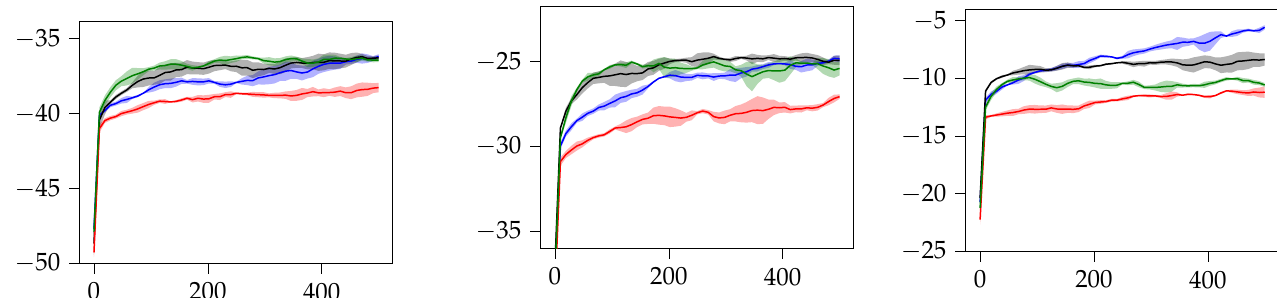
( b ) Total reward during training for the backoff attack case. Horizontal axis correspond to the TRPO iteration, vertical axis is the average reward ± one standard deviation. From left to right: 1/3/10 ASs. Higher is better.